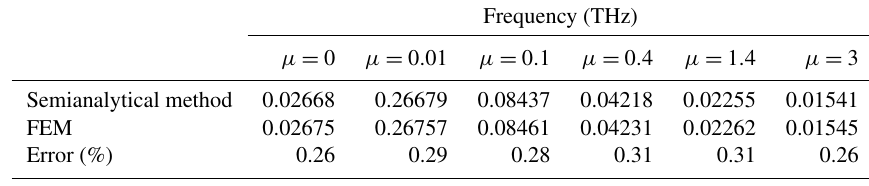
Table 3. The first eigenfrequency of carbon nanotubes for both methods with different nonlocal parameter.